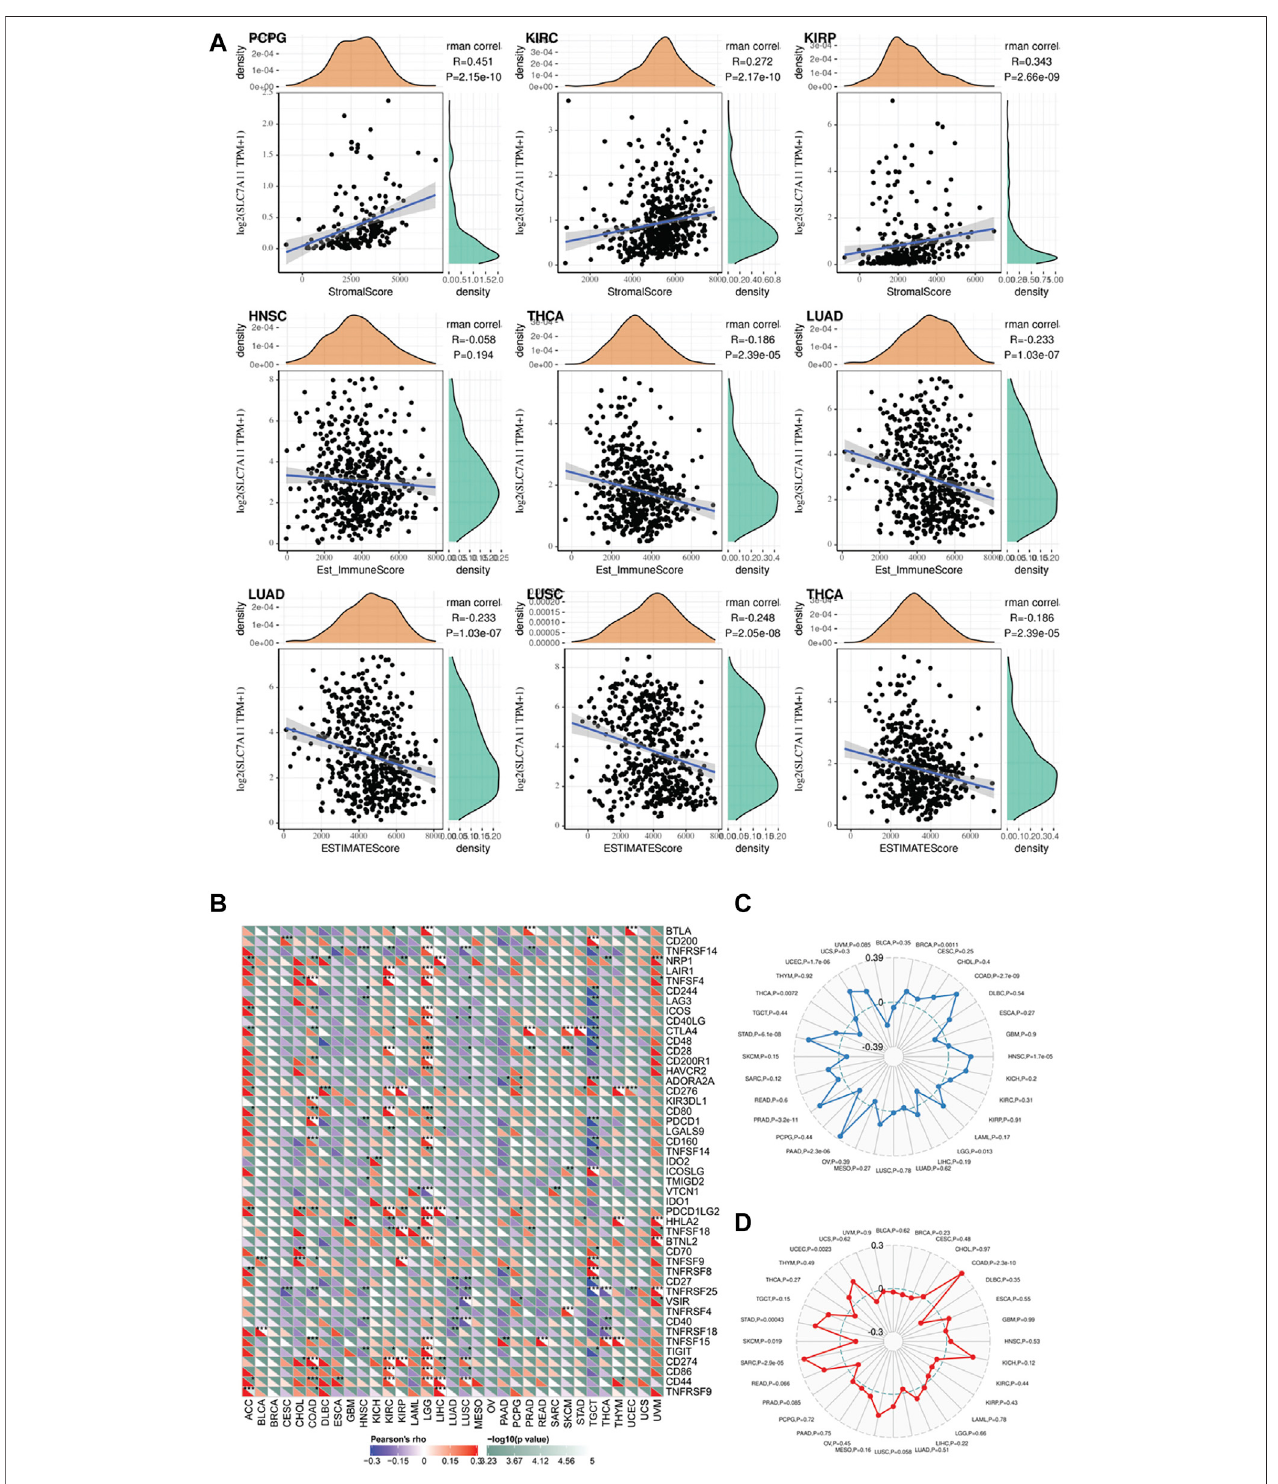
FIGURE5|(A) ThecorrelationbetweenSLC7A11expressionandimmuneandstromalscoreindistinctcancers. (B – D) ExploringthepotentialofSLC7A11inanti- cancer immunity by evaluating its association with immune checkpoint, tumor mutation burden, and microsatellite instability across distinct cancers.